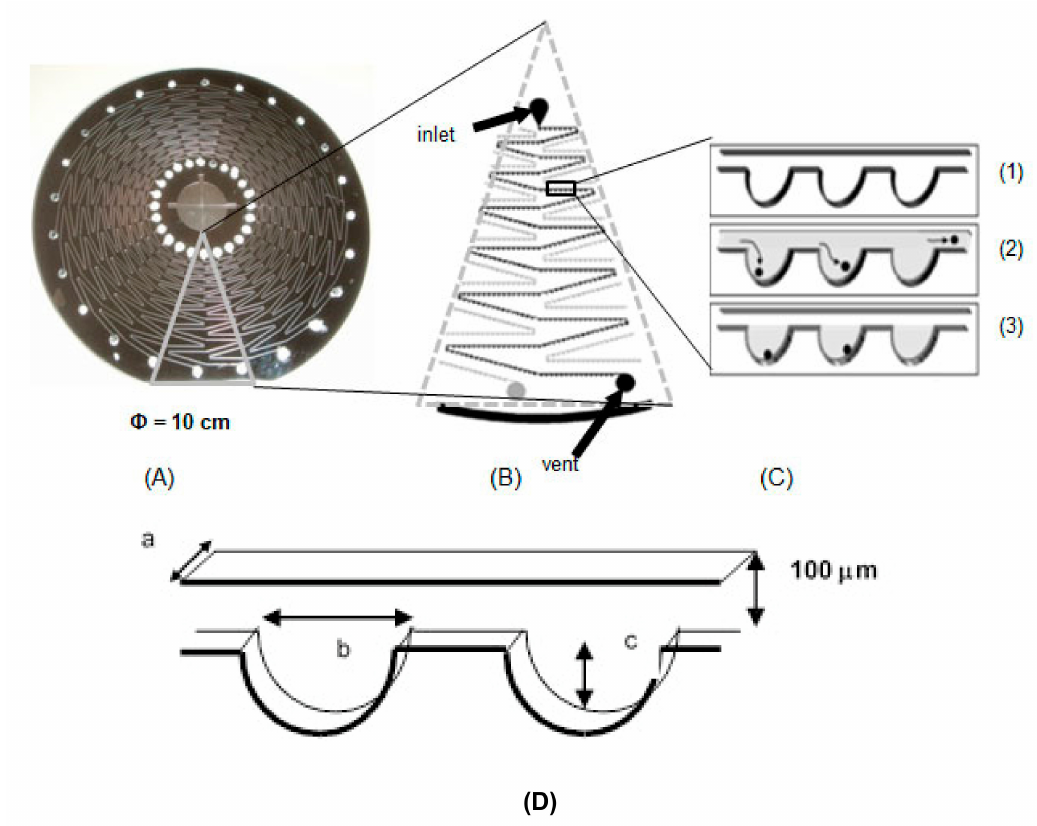
Figure 2. The microfluidic disc device: ( A ) micro fluidic disc device; ( B ) microchannel on the microfluidic disc device; ( C ) microchambers and entrapment of cells. ( 1 ) Microchambers are arrayed along the microchannel; ( 2 ) cell suspension flows through the microchannel; ( 3 ) cells are trapped in microchambers by centrifugal force (3000 rpm, 30 s), ( D ) size of microchannel and microchambers: ( a ) 40 µ m, ( b ) 300 µ m, ( c ) 200 µ